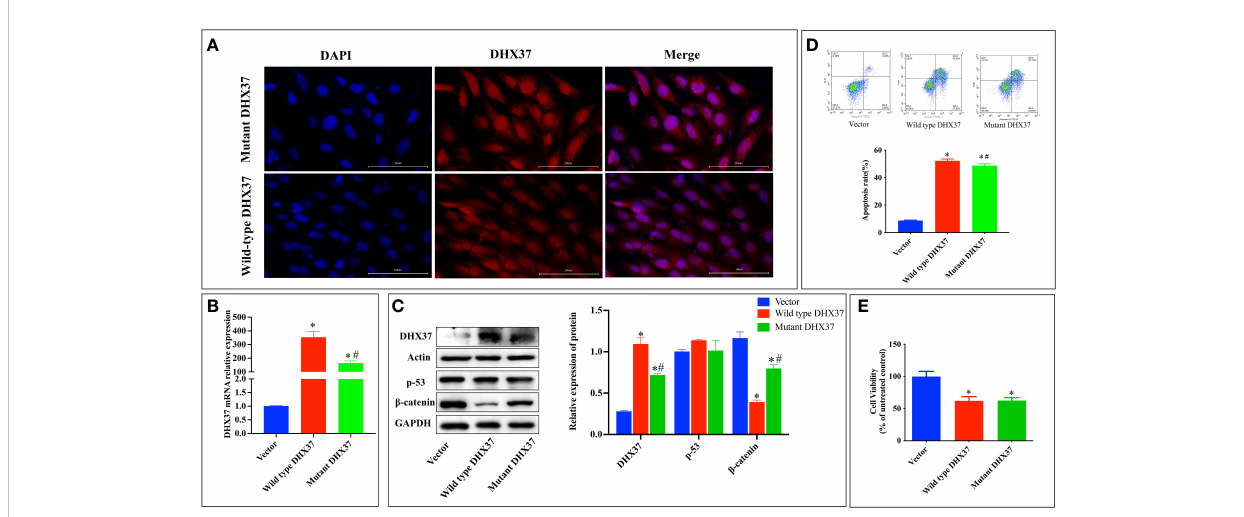
FIGURE 5 In vitro functional studies. (A) Cellular localization of mutant and wild-type DHX37 protein. Human Sertoli cells were transfected with wild-type DHX37 or mutant DHX37 . Immuno fl uorescence was performed on the cells using antibodies against DHX37 (red), and the nucleus was stained by DAPI (blue). Scale bars are 100 m m. The highest concentration of the protein was in the nucleus, although protein was also observed in the cytoplasm. Both wild-type and mutant DHX37 exhibited the same cellular localization. (B) Relative mRNA expression of DHX37 when human Sertoli cells were transfected with empty expressing vector, wild-type DHX37 , and mutant DHX37 . (C) Western blot analysis of DHX37, p53, and the b - catenin protein expression in human Sertoli cells transfected with empty, wild-type, or mutant DHX37 expression vector. Actin and GAPDH were the housekeeping protein used in this Western blot as a loading control. Effects of the DHX37 mutation (S408L) on (D) apoptosis and (E) proliferation of human Sertoli cells transfected with empty, wild-type, or mutant DHX37 expression vector. Statistical analysis was performed with the use of one- way ANOVA followed by multiple comparisons using a post hoc Tukey ’ s test. *p < 0.05 compared with empty expression vector. #p < 0.05 compared with wild-type DHX37